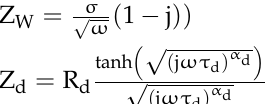
Table 5. Values of the fitting parameters for a B (as-cast) sample at different immersion times in the 411 chlorinated solution .